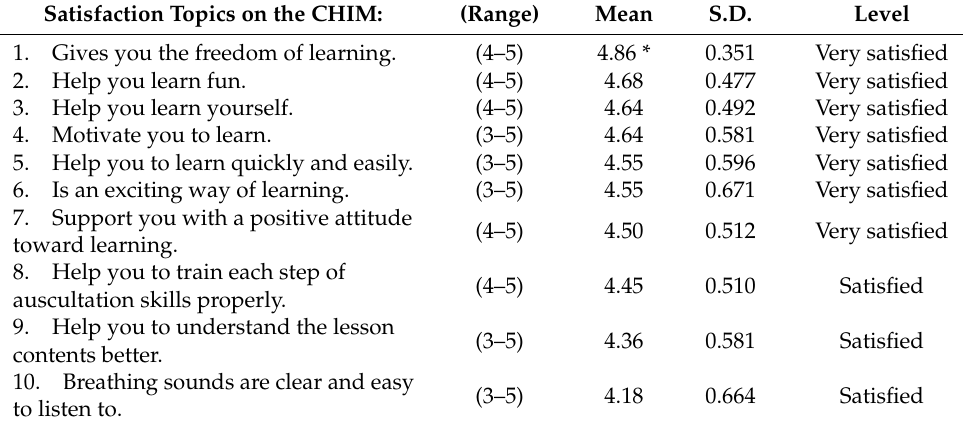
Table 6. The satisfaction assessment topics and results in the experimental group. Satisfaction Topics on the